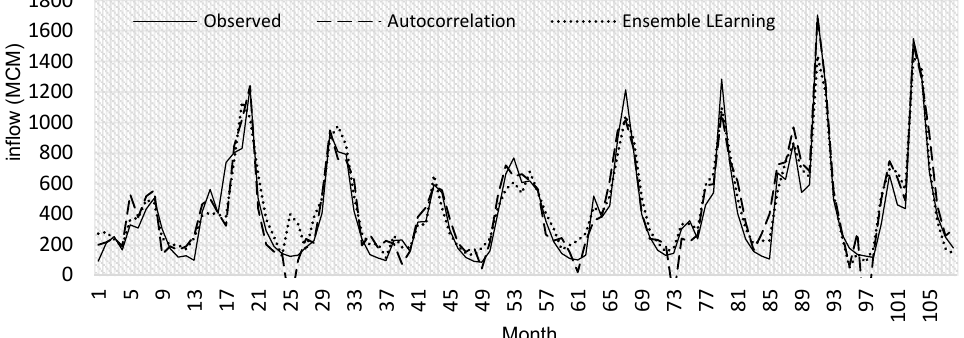
Figure 6. Comparison of observed and forecast data of proposed methods .